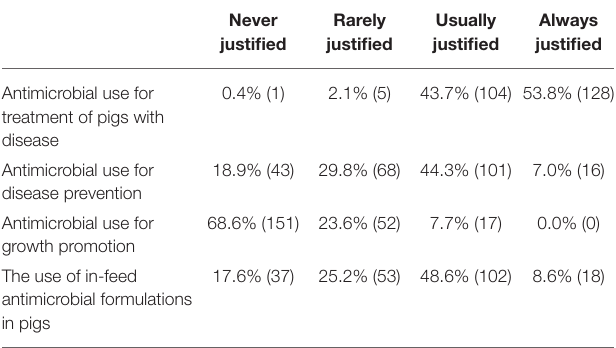
TABLE 5 | Questionnaire responses on the justification of antimicrobial use practices in UK pig production. Never who identified antimicrobial as critical